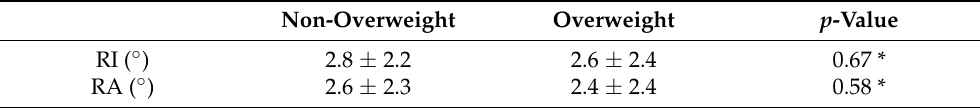
Table 1. Patients’ demographic characteristics.